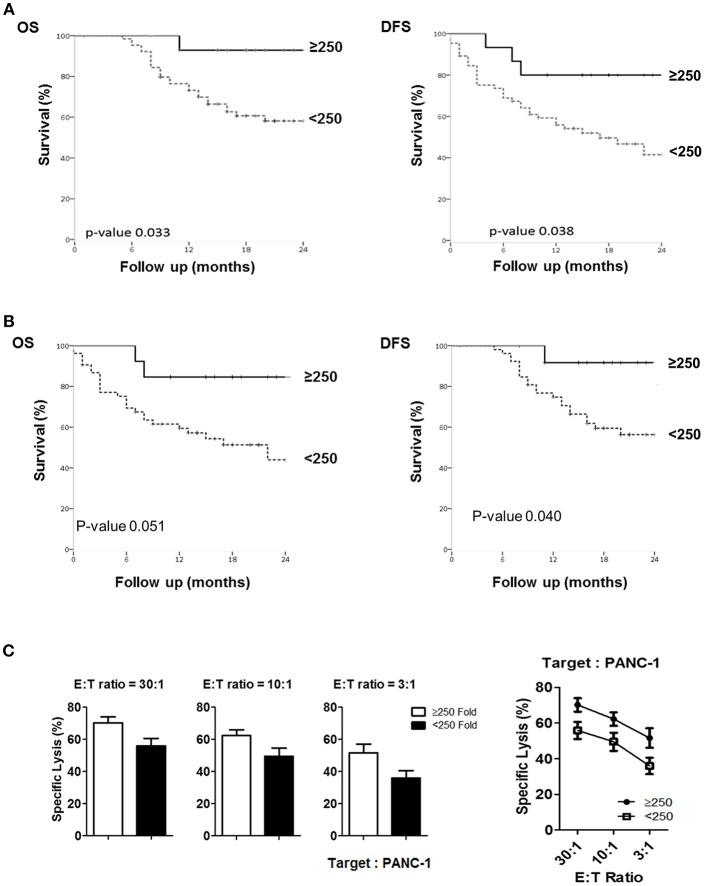
Comparison of actual 2-year survival rate and disease-free survival rate based on NK fold expansion rate. (A) The graphs of 2-year overall survival (OS) and disease-free survival (DFS) rates obtained from 80 patients are shown. (B) The graphs of 2-year overall survival (OS) and disease-free survival (DFS) rates obtained from 66 patients, excluding the patients treated with neo-CTX and/or neo-RTX are shown. (C) Tumor cytotoxicity of NK cells isolated from the patients who exhibited >250 and <250-folds.